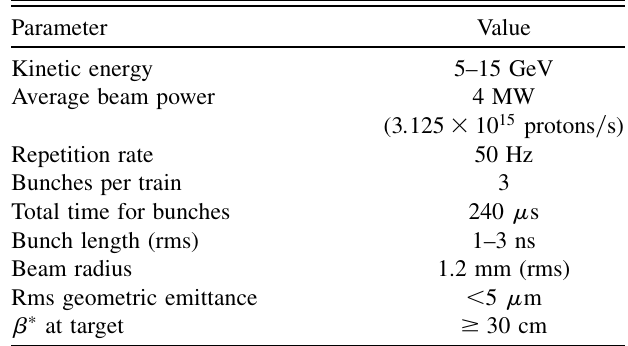
TABLE I. Proton-driver requirements. A proton kinetic energy in the range 5 to 15 GeV has been shown to provide adequate performance. The number of protons, beam radius, (cid:2) (cid:2) , and geometric emittance correspond to the values for an 8 GeV proton